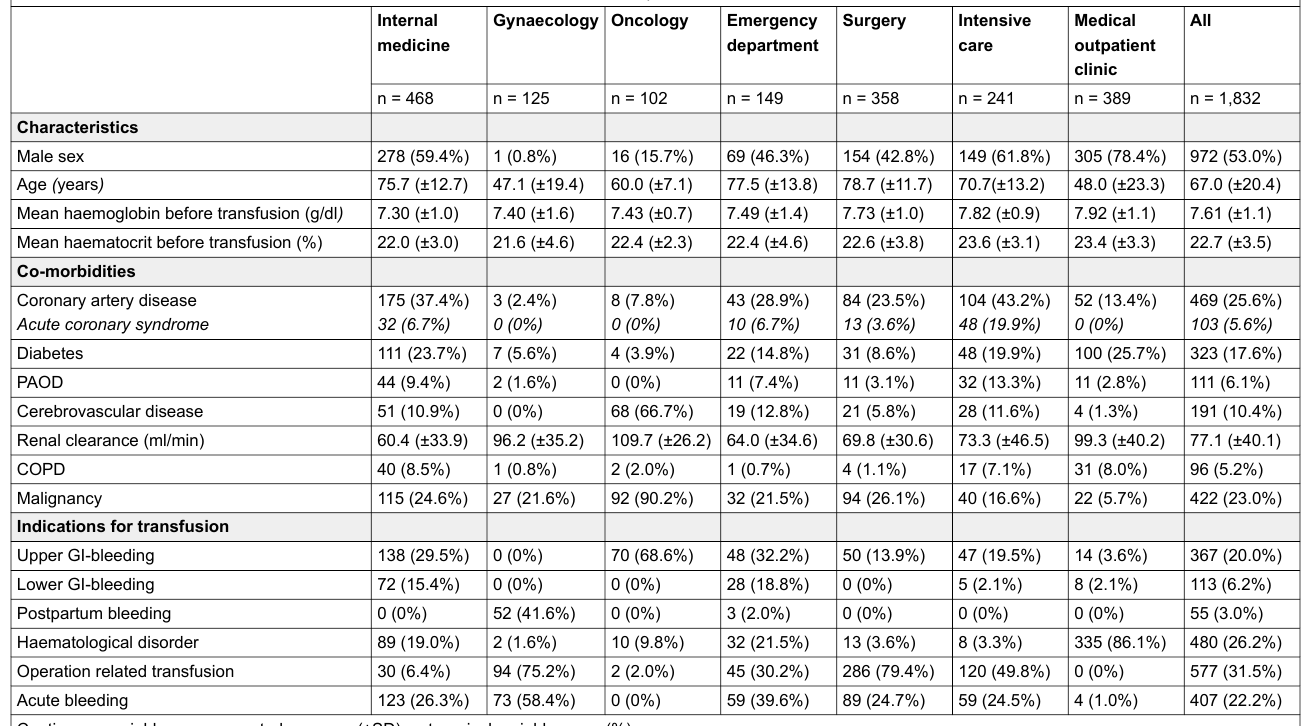
Table 1: Characteristics, co-morbidities and indications for transfusions within the